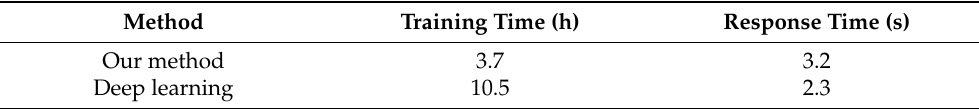
Table 3. Comparison of different methods’ computational